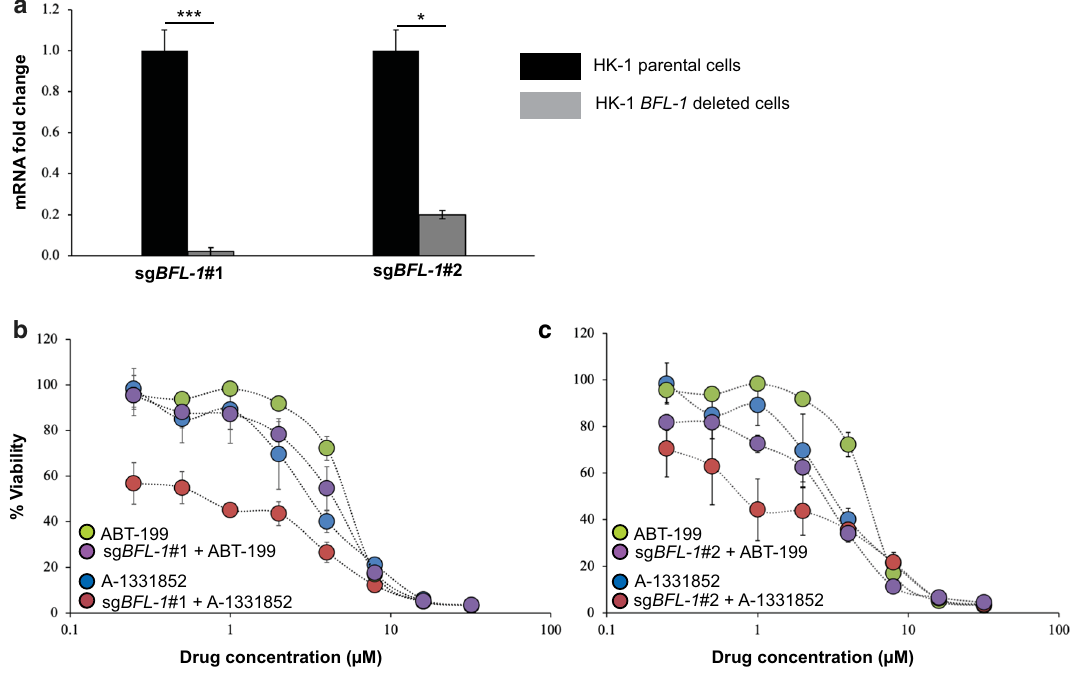
Fig. 4 HK-1 BFL-1 deleted cells were sensitive to treatment of BCL-XL selective inhibitor A-1331852. a Quantitative PCR (qPCR) validation BFL-1 gene deletion in the HK-1 cells. BFL-1 expression levels were normalized to parental cells. Bars indicate the SD of three independent experiments. Statistically significant differences in BFL-1 expression between the parental cell line and the BFL-1 knockout cells are shown as ***p ≤ 0.001 or *p < 0.05 determined by a two-tailed paired T-test. The sensitivity of the HK-1 parental cell line and the b HK-1 sg BFL-1 #1 and c HK-1 sg BFL-1 #2 cells were tested to single-agent treatment of either ABT-199 or A-1331852 (0–32 μM). Points represent the SD of four